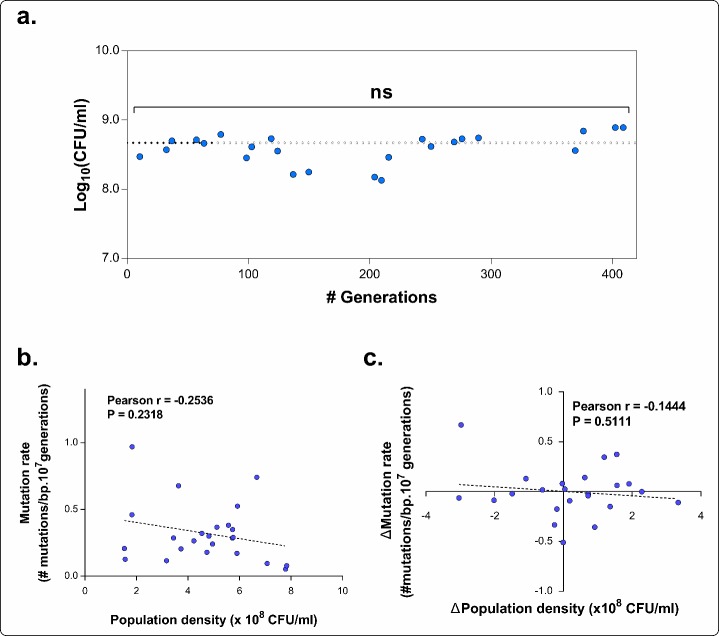
DOI:
http://dx.doi.org/10.7554/eLife.22939.027